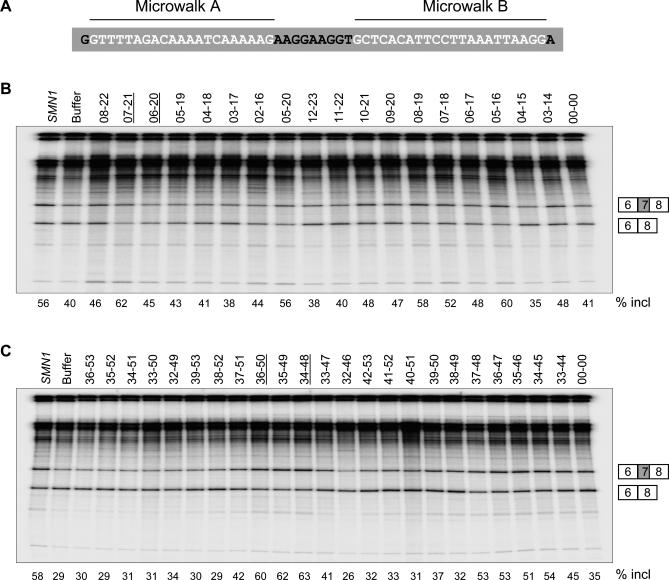
Two ASO Microwalks Assayed by In Vitro Splicing(A) Nucleotides in white show the two microwalk regions.(B) Seventeen new ASOs were screened in microwalk A. The original ASO (06–20) and the improved ASO (07–21) are underlined.(C) Twenty-two new ASOs were screened in microwalk B. The original ASO (36–50) and the improved ASO (34–48) are underlined. SMN2 minigene pre-mRNA was spliced in vitro as in Figure 1, in the presence of each ASO at a concentration of 100 nM. The percentage of exon 7 inclusion in each lane is indicated below each autoradiogram.